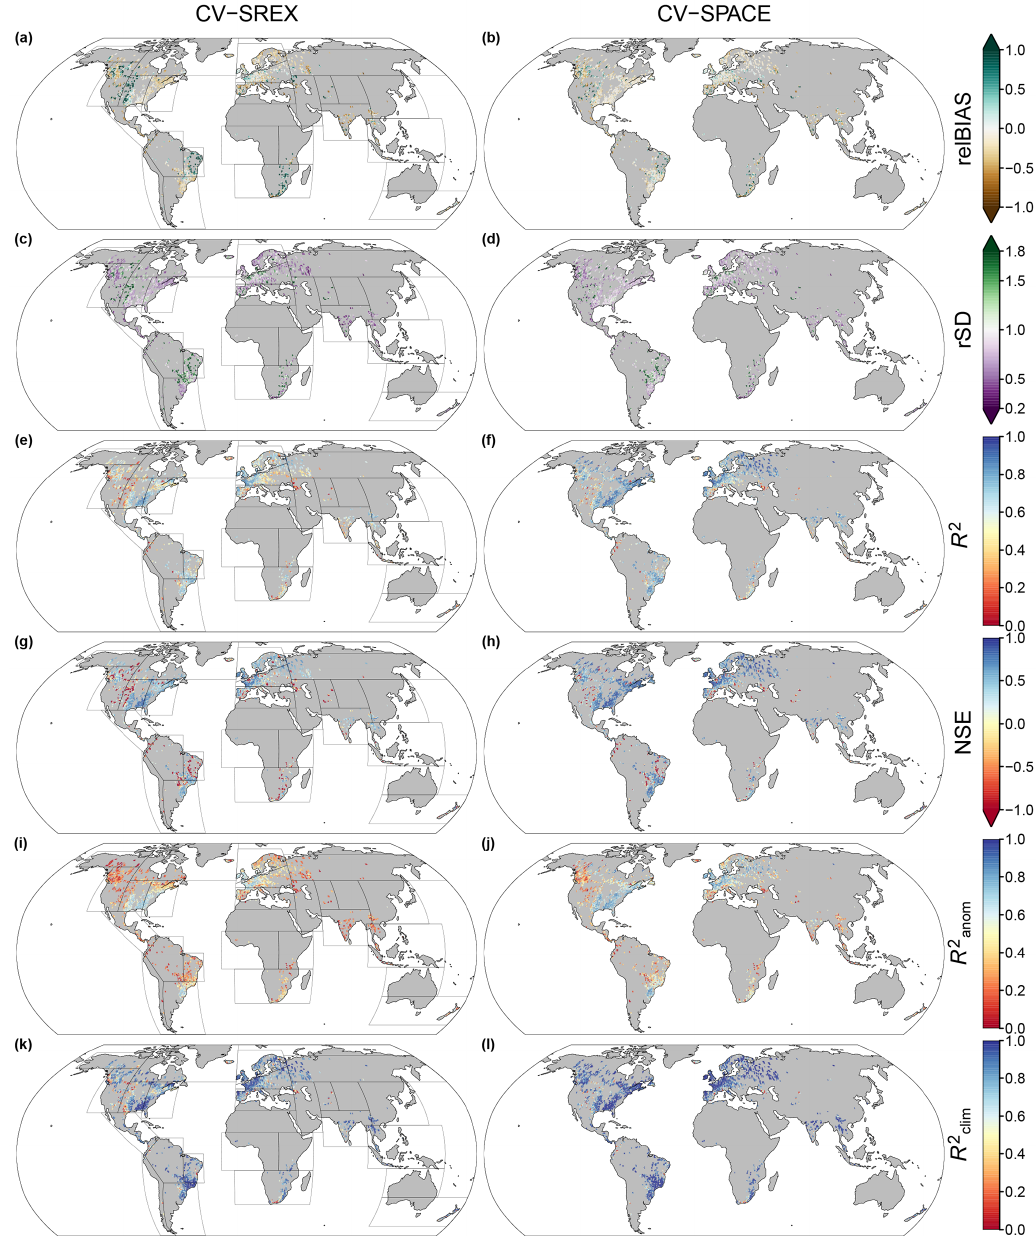
Figure 4. Spatial distribution of the skill scores obtained from the CV-SREX (left) and CV-SPACE (right) experiments. SREX region boundaries are superimposed over the skill maps of